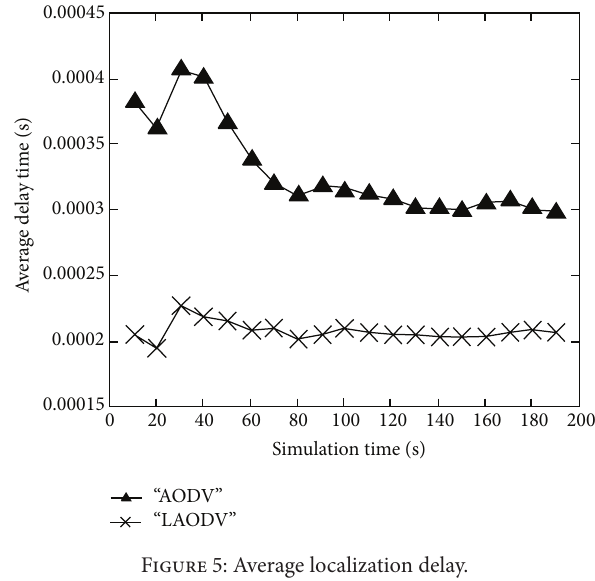
Figure 5: Average localization delay.